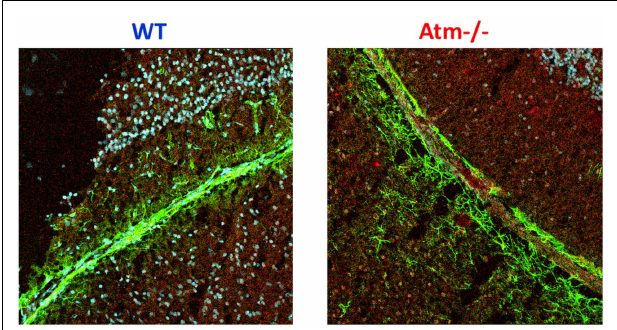
FIGURE 4 |Alterations in the glial-vascular interactions in cerebellar sections derived from Atm − / − mice. Confocal images of cerebellar sections fromWT and Atm − / − mice, labeled for CD31 (red) and GFAP (green).